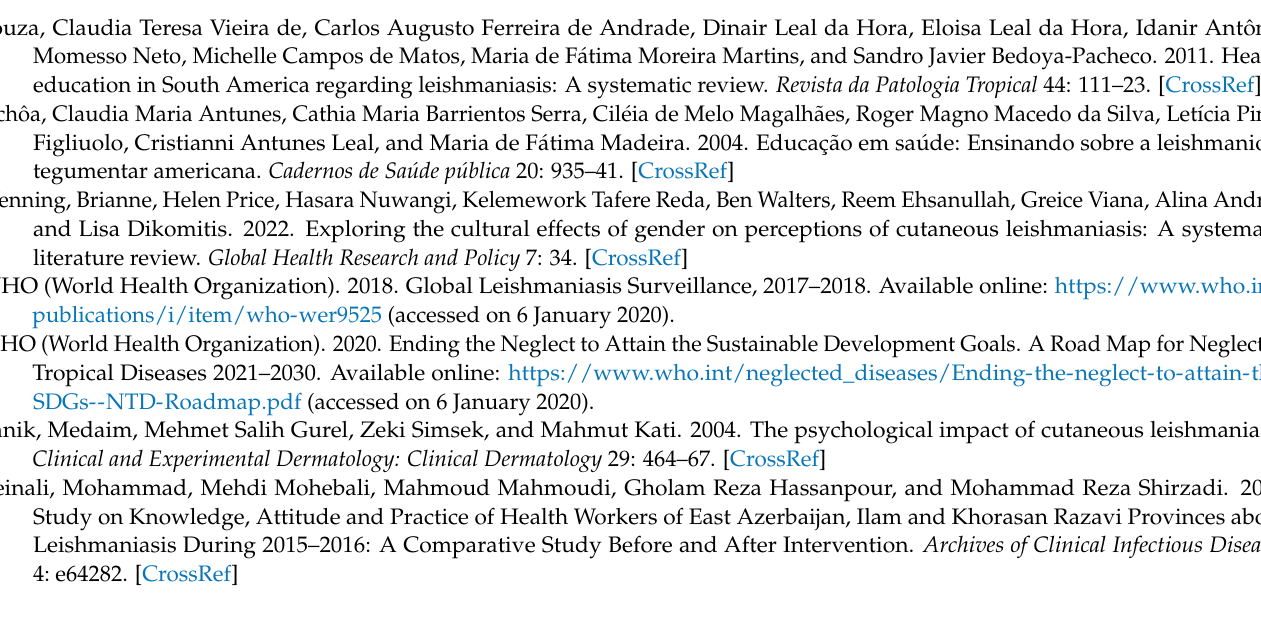
Figliuolo, Cristianni Antunes Leal, and Maria de F á tima Madeira. 2004. Educaç ã o em sa ú de: Ensinando sobre a